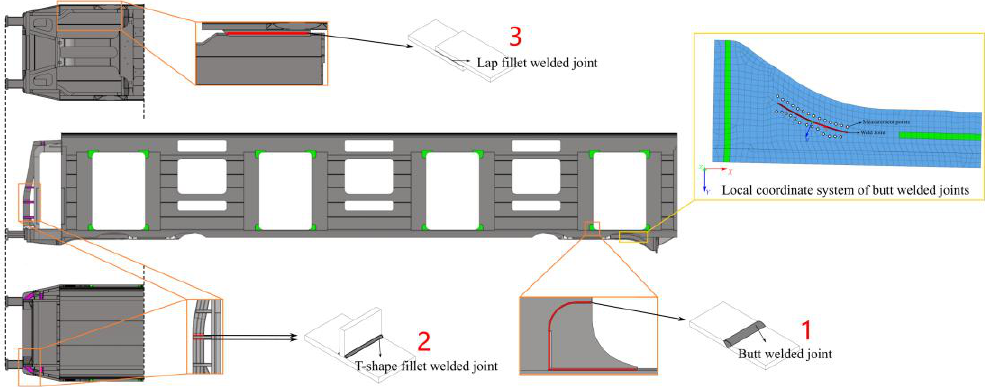
Figure 3. Schematic diagram of the head car body.